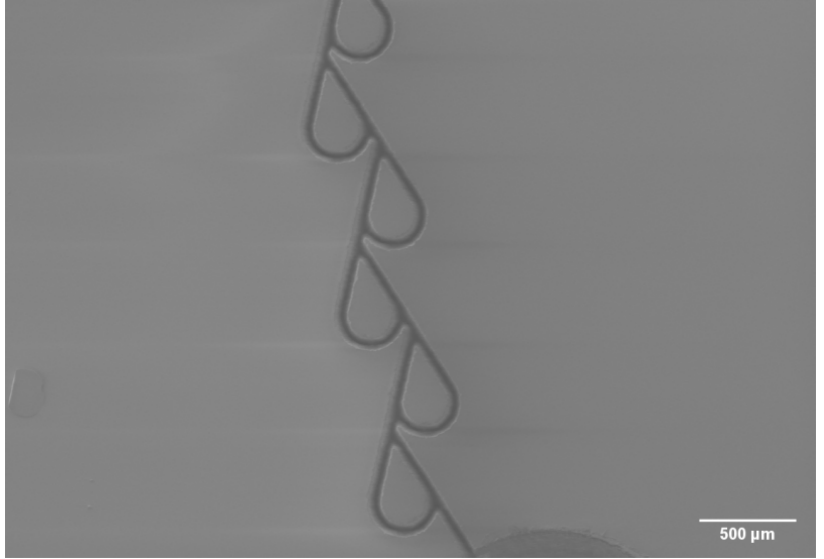
Figure 7. SEM image of final Tesla valve before